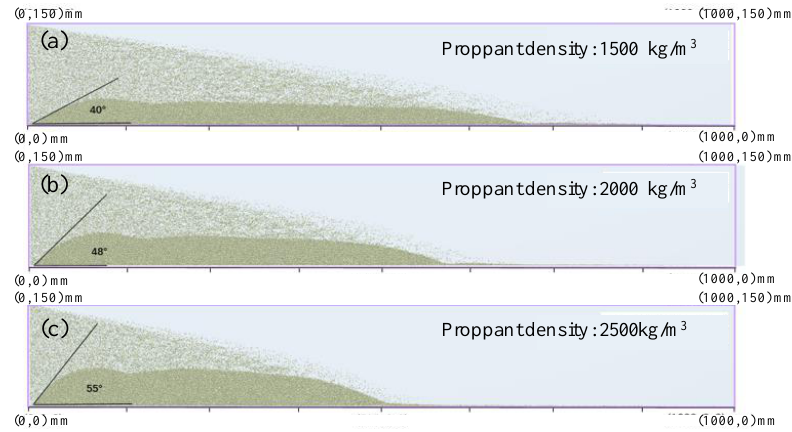
Figure 6. Proppant placement under di ff erent proppant densities: ( a ) 1500, ( b ) 2000, and ( c ) 2500 kg / m 3 .